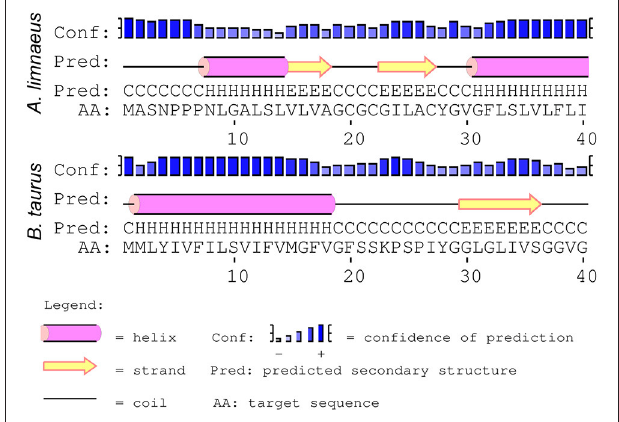
FIGURE 6 | Consensus motifs of CSB-1 (top) and CSB-2 (bottom) found in the D-loops of species used in this study. CSBs were found by searching the mtgenomes using conserved motifs based on previous work by Broughton et al. (2001).